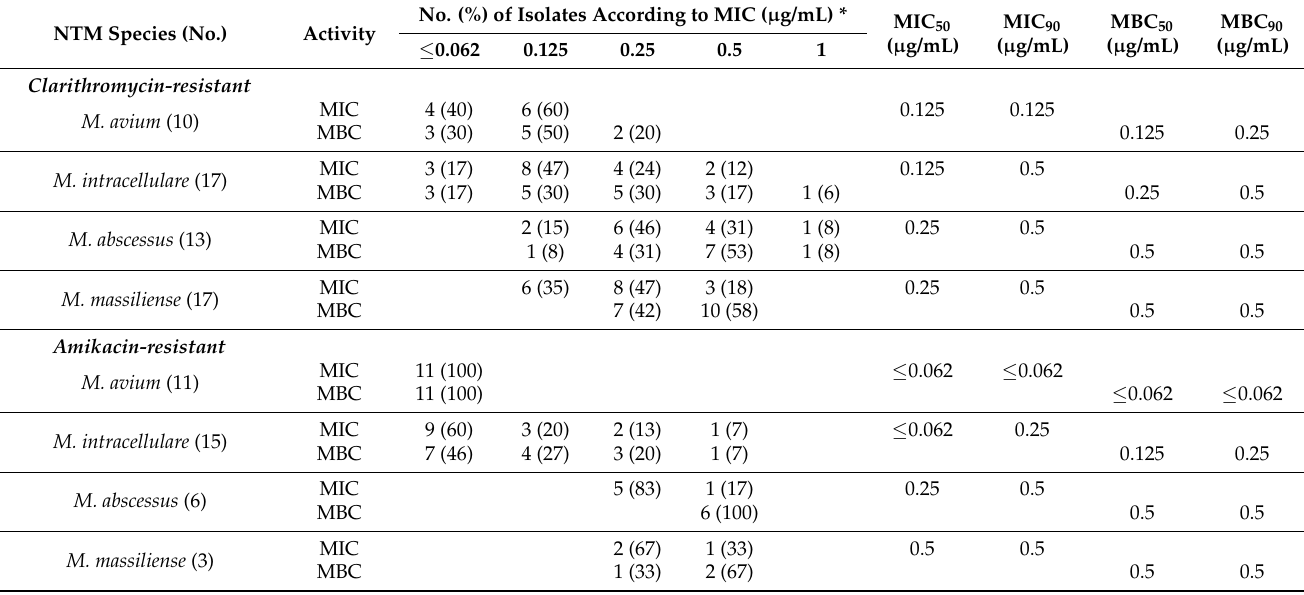
Table 2. MIC 50 , MIC 90 , MBC 50 , and MBC 90 values of clofazimine for 57 clarithromycin-resistant and 35 amikacin-resistant NTM isolates *.